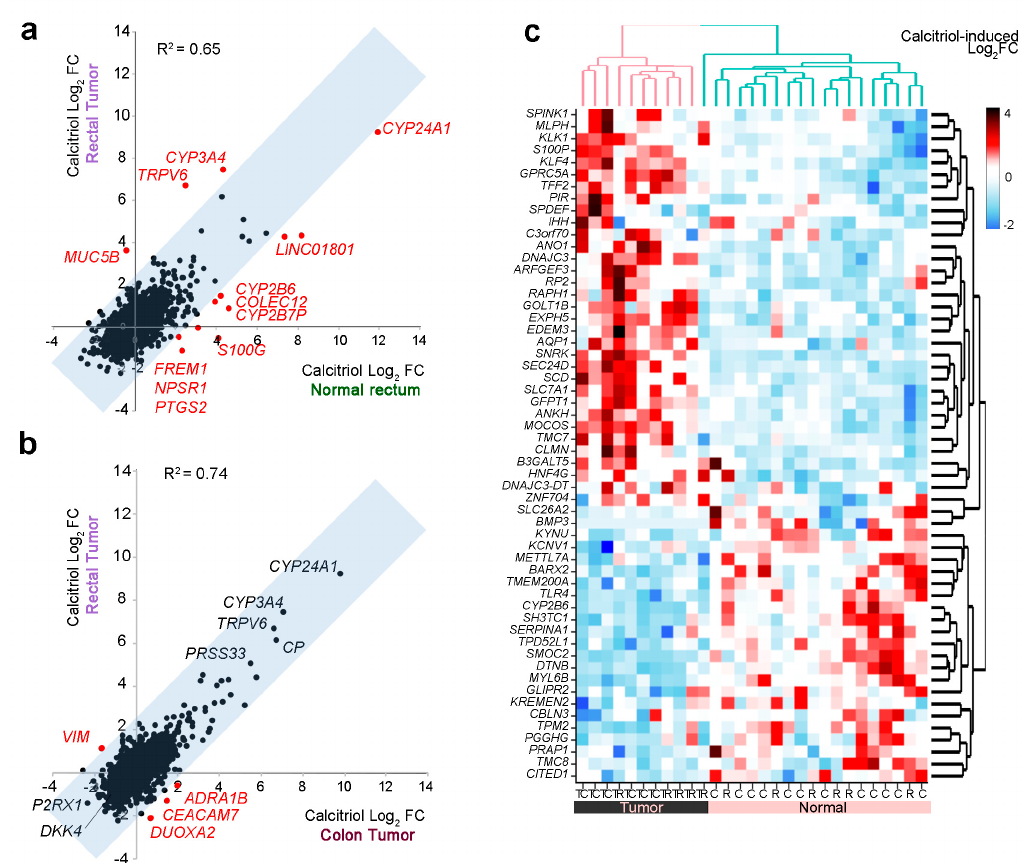
Figure 6. Comparison of calcitriol effects on the gene expression profiles of rectal tumor and normal rectum organoids. ( a ) Comparison of the calcitriol response of rectal tumor and normal rectum organoids ( n = 6 of each type). Genes showing differential regulation between the two organoid types are shown in red. ( b ) Comparison of the calcitriol response in colon tumor and rectal tumor organoids ( n = 6 of each type). Genes in black within the gray-shaded correlation zone are not considered differentially regulated because the Log 2 FC difference does not exceed that of the replicate assays presented in Figure 5a. ( c ) Heatmap showing genes differentially regulated by calcitriol in normal and tumor organoids. The heatmap shows calcitriol regulation (Log 2 FC) in the transcriptome of 29 organoid cultures (colon, n = 12; colon tumor, n = 6; rectum, n = 6; rectal tumor, n = 5). The RNA-seq data for six of the normal colon organoid cultures and the six colon tumor organoid cultures were obtained from GSE100785 [33].